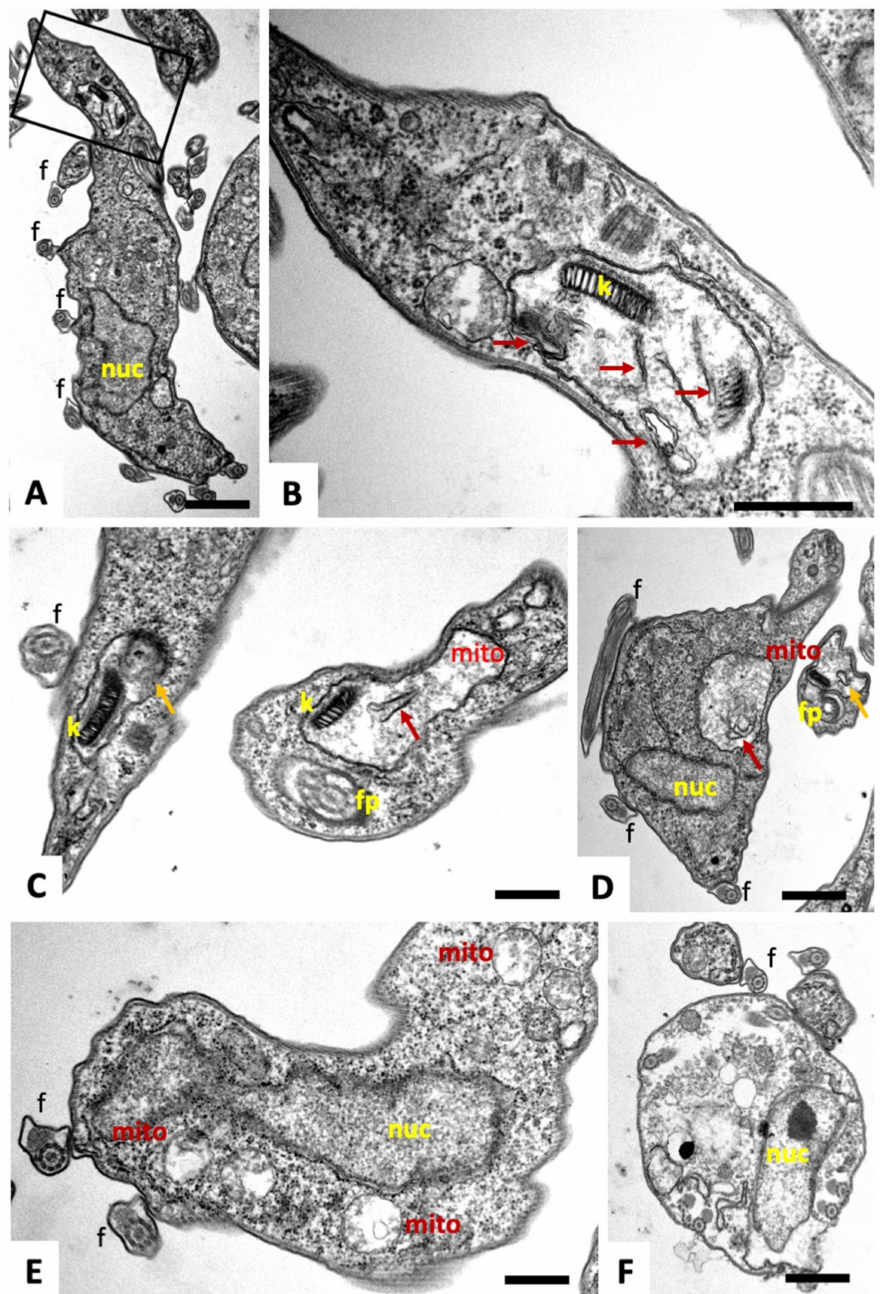
Figure 5. TEM of T. brucei bloodstream forms treated with 200 nM of compound 1 for 4 h. ( A ) is a lower magnification view of a longitudinal section, the boxed region at the posterior end is magnified in ( B ). ( C ) shows two other parasites with altered kinetoplast (k), ( D , E ) show sections through the mitochondrion in other parts of the cell. Arrows point to the structurally altered mitochondrial matrix, characterized by low electron density and potentially membranous content of unknown nature (red arrows), and membrane fragments (orange arrows). ( F ) shows parasites with a more severely altered structural organization and apparent loss of cytoplasmic content. mito = mitochondrion, k = kinetoplast, f = flagellum, fp = flagellar pocket, nuc = nucleus. Bars in A = 0.8 µ m, B = 0.35, C = 0.21 µ m, D = 0.4 µ m, E = 0.21 µ m, F = 0.35 µ